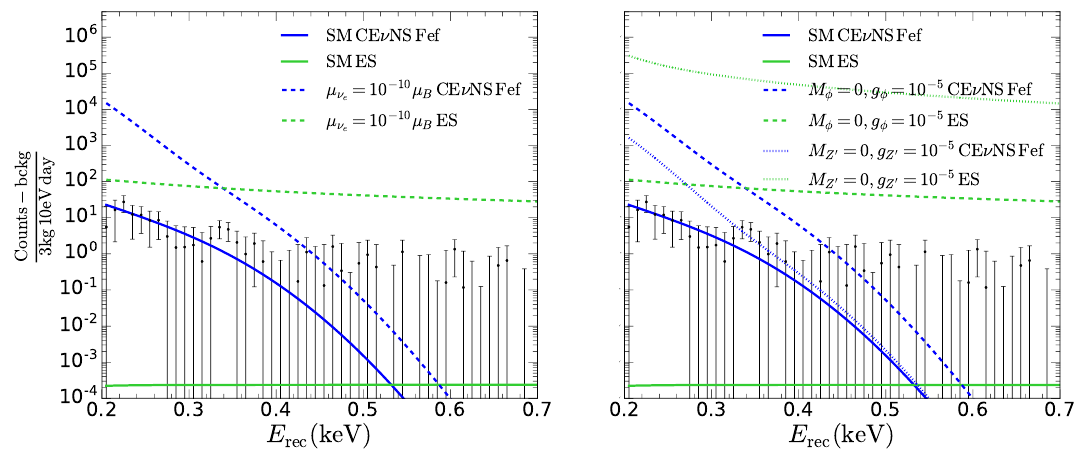
Figure 1 . Left panel: spectral rate of signal events from CE ν NS and ¯ ν e e − scattering in the SM and from the electromagnetic scattering induced by a neutrino magnetic moment µ ν = 10 − 10 µ B . Right e panel: spectral rate of signal events from CE ν NS and ¯ ν e e − scattering in the SM and for the contribu- tion induced by an interaction mediated by a massless scalar boson (dashed lines) and by a massless vector boson (dotted lines), assuming universal couplings (see table 2). For a vector mediator, we show the addition of both contributions, the purely vector boson contribution and the interference with the SM (see eq. (2.14)). In both panels we compare the spectra to data, after subtracting the best-fit background model assuming only the SM signal. All results in both panels are depicted for the Fef model of the quenching factor (for interactions with nuclei) and assuming E I, min = 3